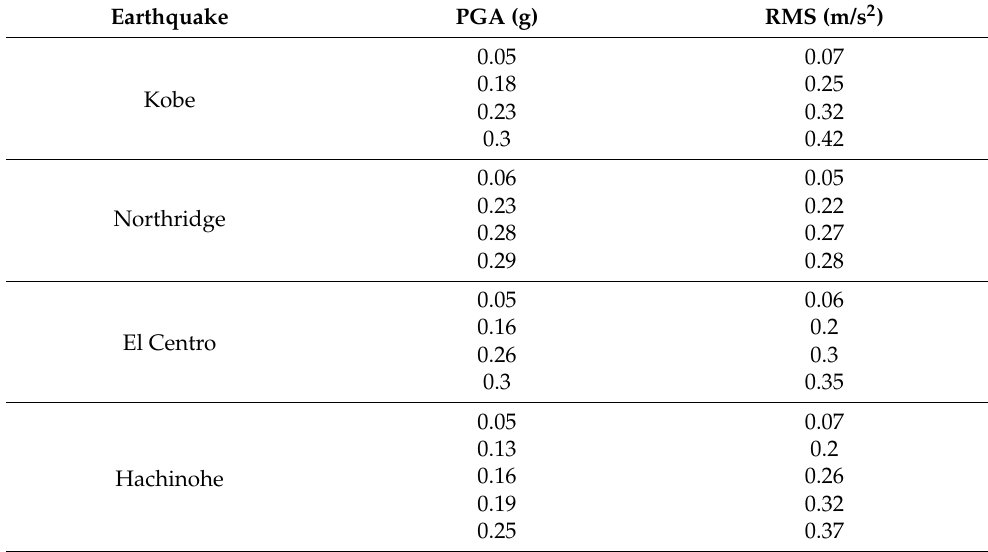
Table 3. Natural earthquakes’